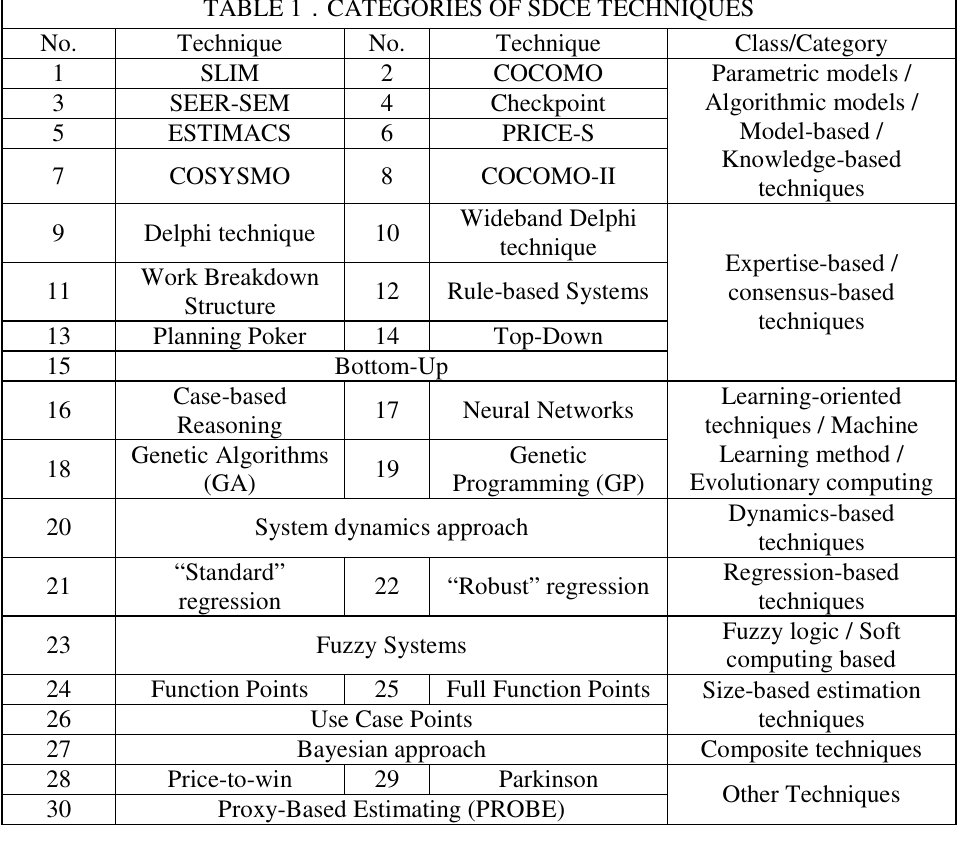
TABLE 1 ． CATEGORIES OF SDCE